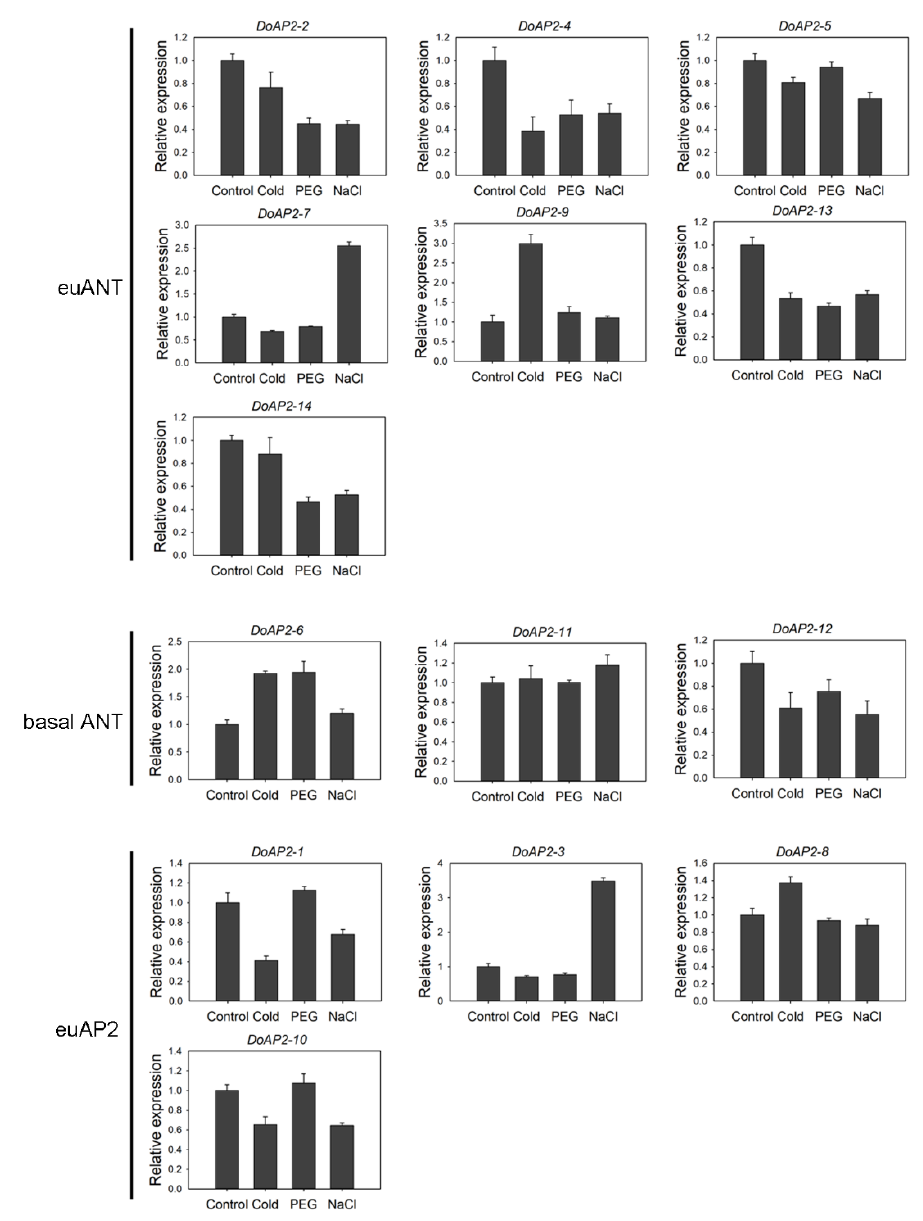
Figure 6. Expression analysis of DoAP2 genes in response to abiotic stresses (cold, PEG and NaCl) by qRT-PCR. PEG treatment, 15% polyethylene glycol (PEG)-6000; NaCl treatment, 250 mM NaCl; cold treatment, 4 °C. Each data bar represents the mean ± standard deviation (SD) of three biological replicates ( n = 3).